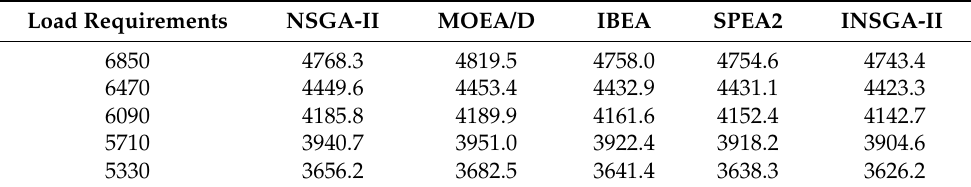
Table 8. Comparison of the optimization results of different algorithms in Case